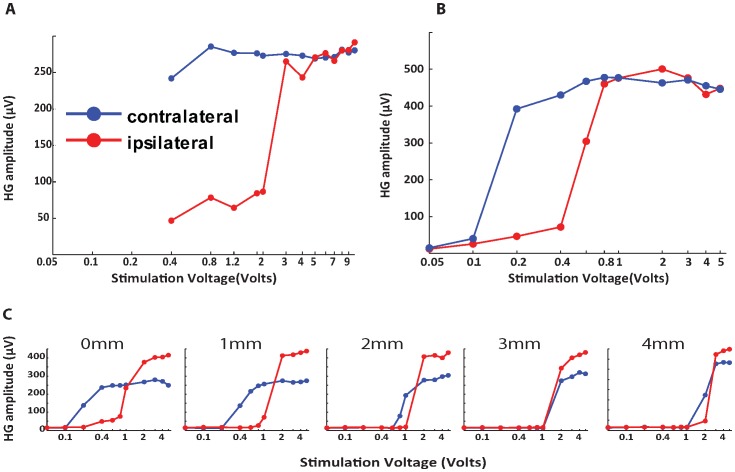
Ipsilateral Versus contralateral spinal cord stimulation.High gamma response recorded from a subdural grid placed on the right cerebral hemisphere plotted as a function of spinal cord stimulation voltage (scale is log10 separated). The red trace denotes ipsilateral SCS (right-sided stimulation) and the blue trace denotes contralateral SCS (left-sided stimulation) in Sheep 1 intradural series (A), Sheep 4 intradural series (B), and Sheep 4 epidural series (C). The numbers above the dotted line in C denote the distance in millimeters of the neurostimulating probe from the dorsal aspect of the spinal dura mater.